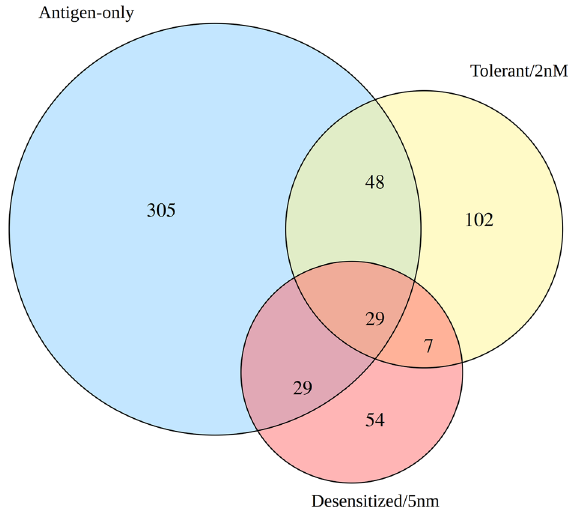
Figure 4. Area proportional Venn Diagram comparing DEGs lists obtained in all three